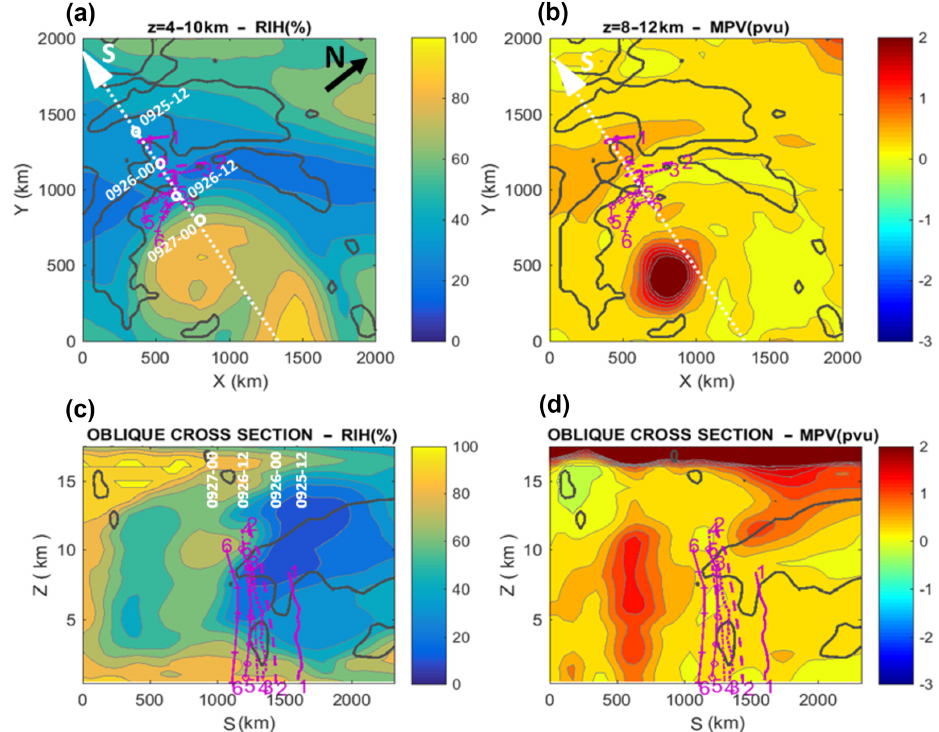
Figure 13. As in Fig. 7, except for the domain shown in Fig. 5c, in the period 25 September at 12:00UTC to 26 September at 18:00UTC, and six tracks of IAGOS aircraft during take-offs and landings on 25–26 September in the vicinity of Typhoon Megi.